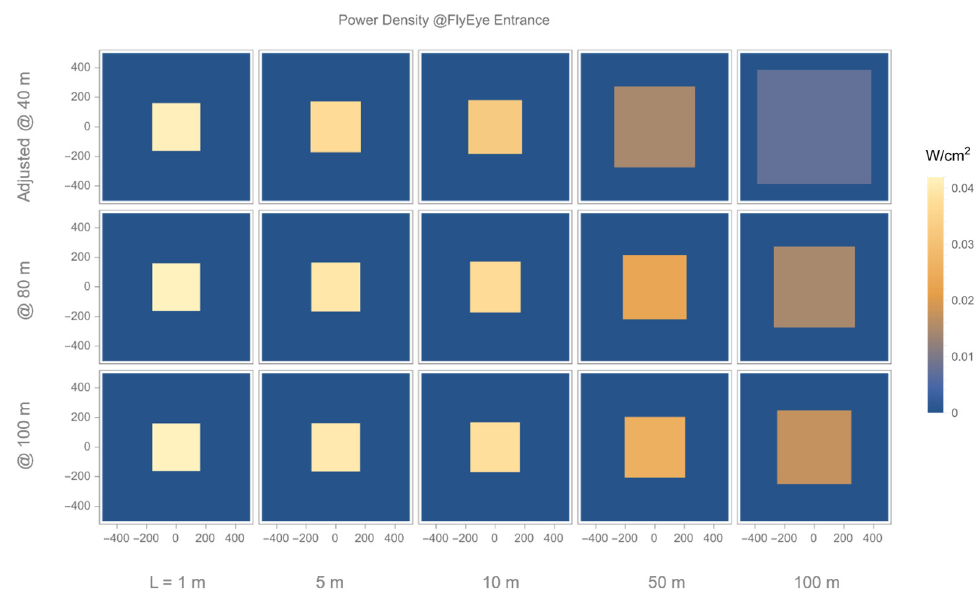
Figure 4. Power density of the incident beam at fly eye module’s entrance.